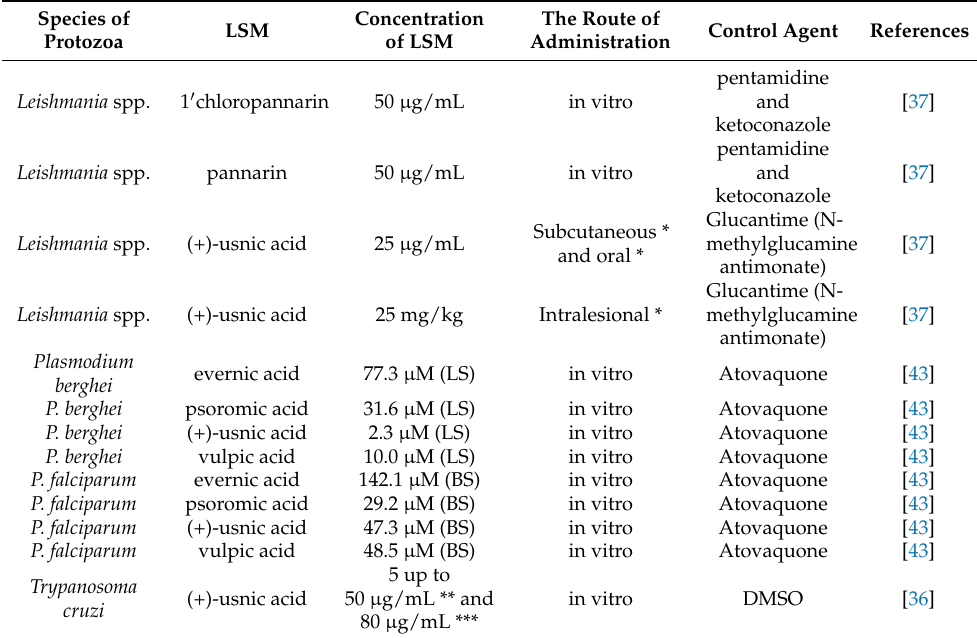
Table 4. Concentration (dosage) and method (the route of administration) in applying LSMs on the given species of protozoa.